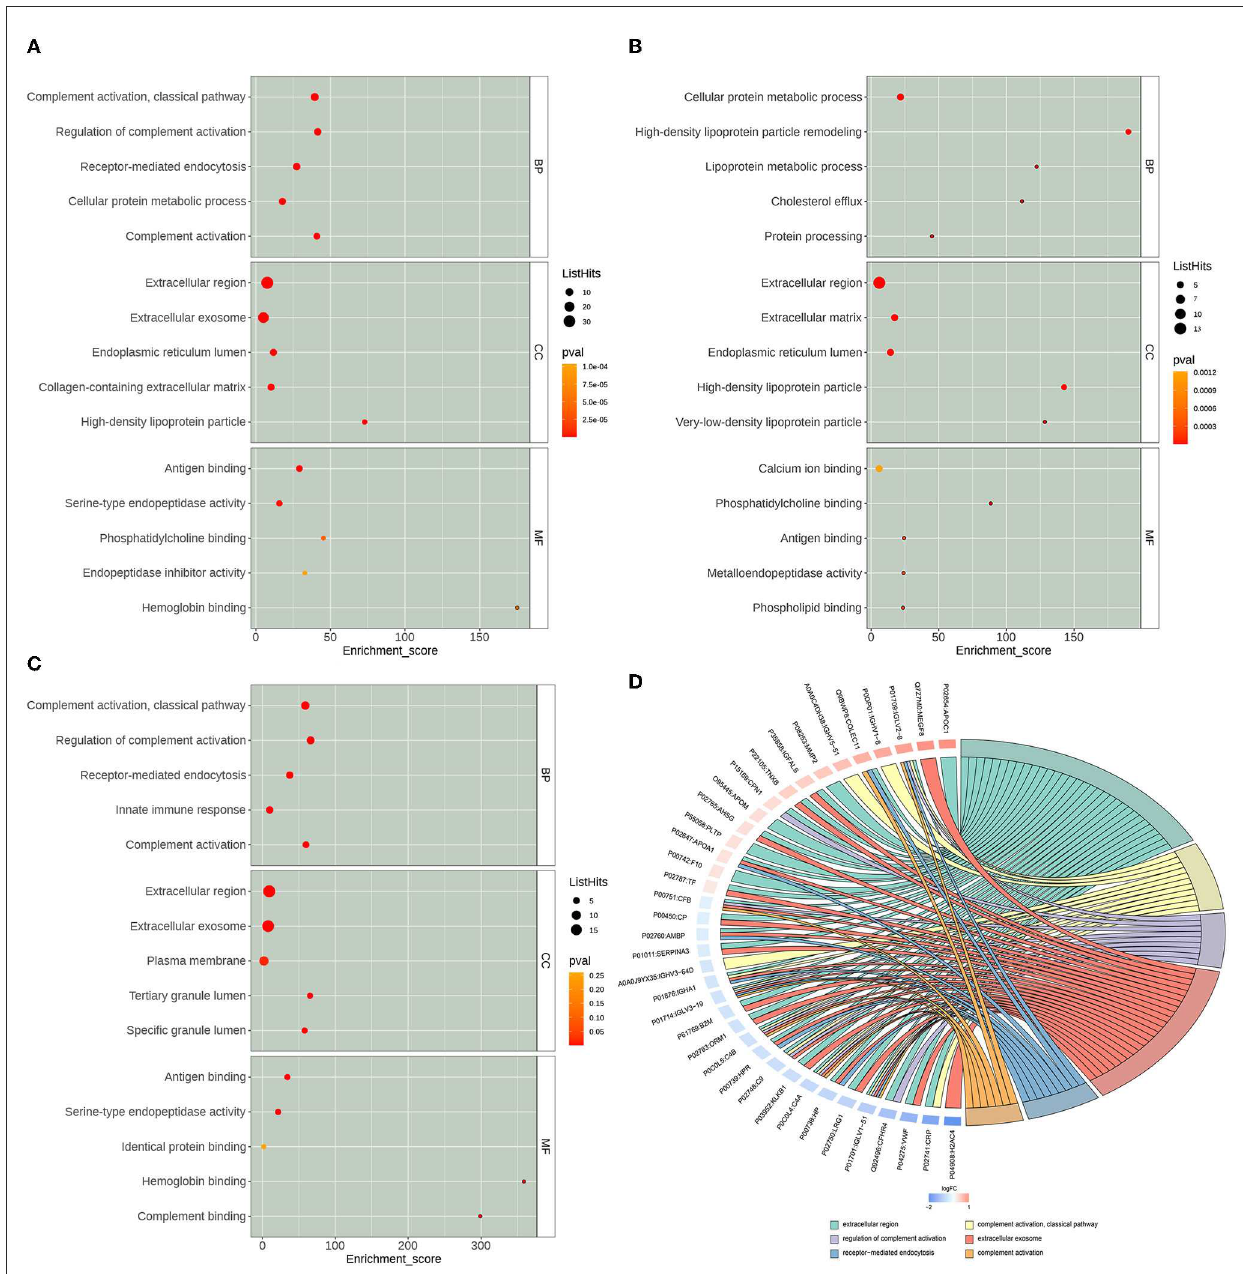
FIGURE4 Gene Ontology (GO) enrichment analysis results. The x-axis Enrichment Score in the bubble diagram is the enrichment score, and the y-axis is the top 5 term information of BP, Biological Process; CC, Cell Component; MF, Molecular Function, respectively. (A) The top 15 GO terms of all differentially expressed proteins. (B) The top 15 GO terms of the up-regulated expressed proteins. (C) The top 15 GO terms of the down-regulated expressed proteins. (D) GO enrichment analysis chord diagram. Protein:gene name on the left, selected GO term on the right, red indicates up-regulated, and blue indicates